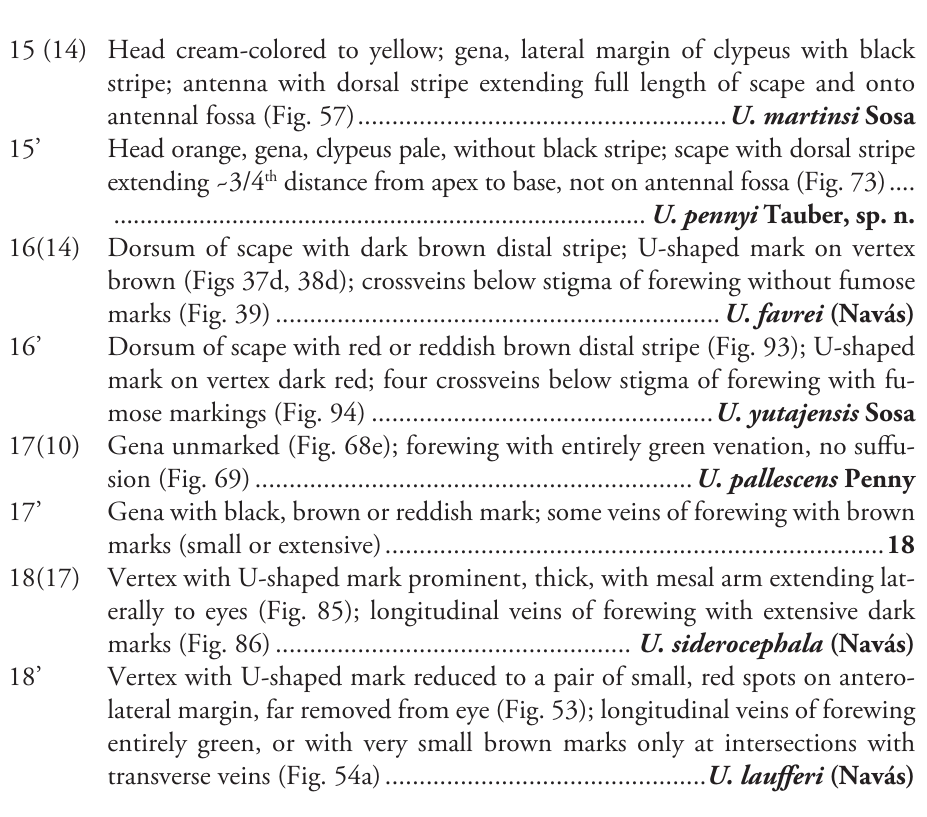
15 (14) Head cream-colored to yellow; gena, lateral margin of clypeus with black stripe; antenna with dorsal stripe extending full length of scape and onto antennal fossa (Fig. 57) ...................................................... U. martinsi Sosa Head orange, gena, clypeus pale, without black stripe; scape with dorsal stripe extending ~3/4 th distance from apex to base, not on antennal fossa (Fig. 73) .... 16(14) Dorsum of scape with dark brown distal stripe; U-shaped mark on vertex brown (Figs 37d, 38d); crossveins below stigma of forewing without fumose marks (Fig. 39) ................................................................. U. favrei (Navás) 16’ Dorsum of scape with red or reddish brown distal stripe (Fig. 93); U-shaped mark on vertex dark red; four crossveins below stigma of forewing with fu- mose markings (Fig. 94) .................................................. U. yutajensis Sosa 17(10) Gena unmarked (Fig. 68e); forewing with entirely green venation, no suffu- sion (Fig. 69) ................................................................ U. pallescens Penny 17’ Gena with black, brown or reddish mark; some veins of forewing with brown marks (small or extensive) ......................................................................... 18 18(17) Vertex with U-shaped mark prominent, thick, with mesal arm extending lat- erally to eyes (Fig. 85); longitudinal veins of forewing with extensive dark marks (Fig. 86) .................................................... U. siderocephala (Navás) 18’ Vertex with U-shaped mark reduced to a pair of small, red spots on antero- lateral margin, far removed from eye (Fig. 53); longitudinal veins of forewing entirely green, or with very small brown marks only at intersections with transverse veins (Fig. 54a) ............................................... U. laufferi